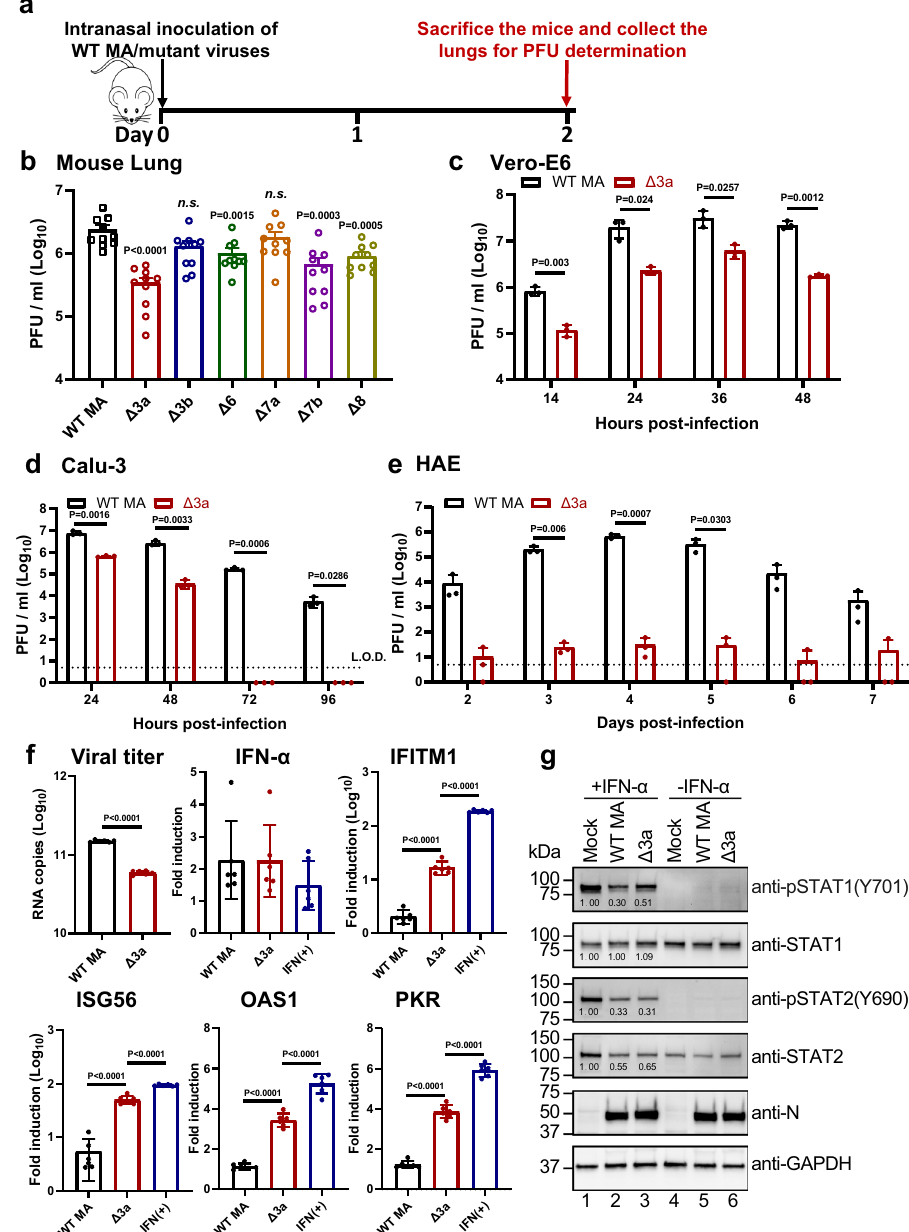
Fig.5|ORF3adeletionismainlyresponsiblefortheattenuationof Δ 3678virus through interfering with STAT1 phosphorylation during type-I interferon sig- naling. a , b Analysis of individual ORFs in BALB/c mice. a Experimental design. b Lung viral loads from mice infected with different ORF-deletion viruses. Dots represent individual animals ( n =10). The mean±standard error of the mean is presented. A non-parametric two-tailed Mann – Whitney test was used to deter- mine the statistical difference between the WT andORF-deletion groups. P values were adjusted using the Bonferroni correction to account for multiple compar- isons. Differences were considered signi fi cant if p <0.0083. c – e Replication kinetics of Δ 3a virus in Vero-E6 ( c ), Calu-3 ( d ), and HAE ( e ) cells. Dots represent individual biological replicates ( n =3). The values represent the mean±standard deviation. An unpaired two-tailed t test was used to determine signi fi cant differ- ences. f ORF3a deletion increases ISG expression in Δ 3a-infected A549-hACE2 cells. Viral RNA copies and mRNA levels of IFN- α , IFITM1, ISG56, OAS1, PKR, and GAPDHweremeasured byRT-qPCR. GAPDHwasusedtonormalize theISGmRNA